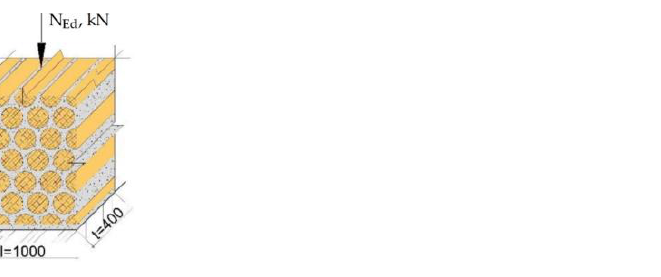
Figure 8. The design scheme of the considered fragment of the cordwood wall.